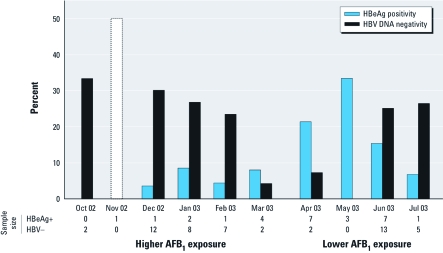
Seasonal variation of HBeAg positivity (HBeAg+) and HBV DNA negativity (HBV–) in HBsAg-positive subjects. The number of individuals sampled each month are given. The value for November 2002 was not considered because the sample size was too small.